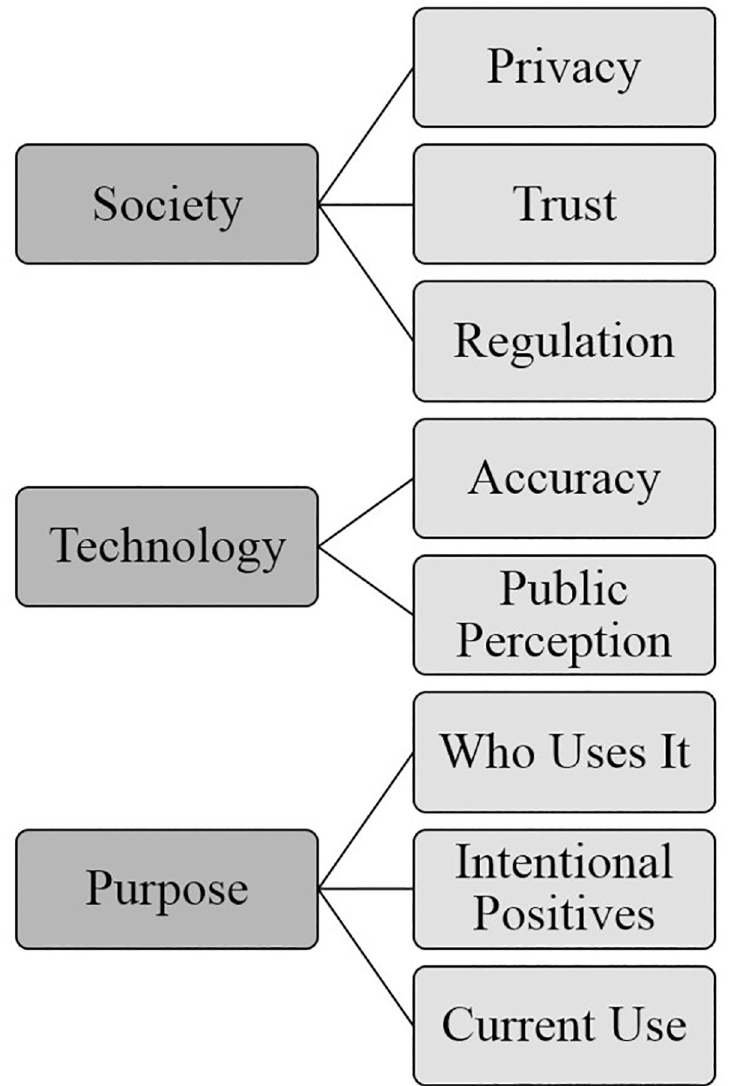
Fig 1. Focus group overarching themes. Graphical representation of overarching themes and themes identified from focus groups conducted in the UK, Australia and